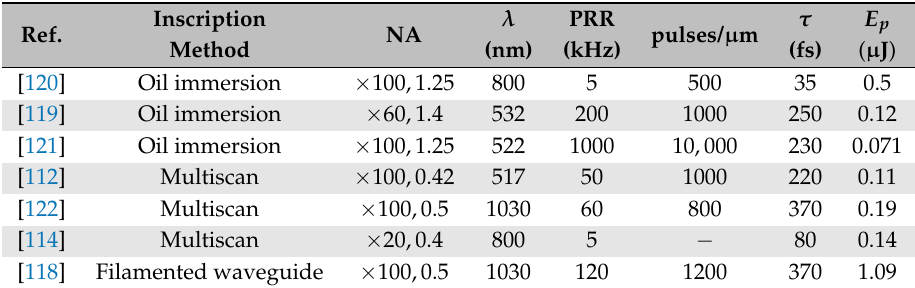
Table 2. Inscription parameters of cladding waveguides (CWG) in